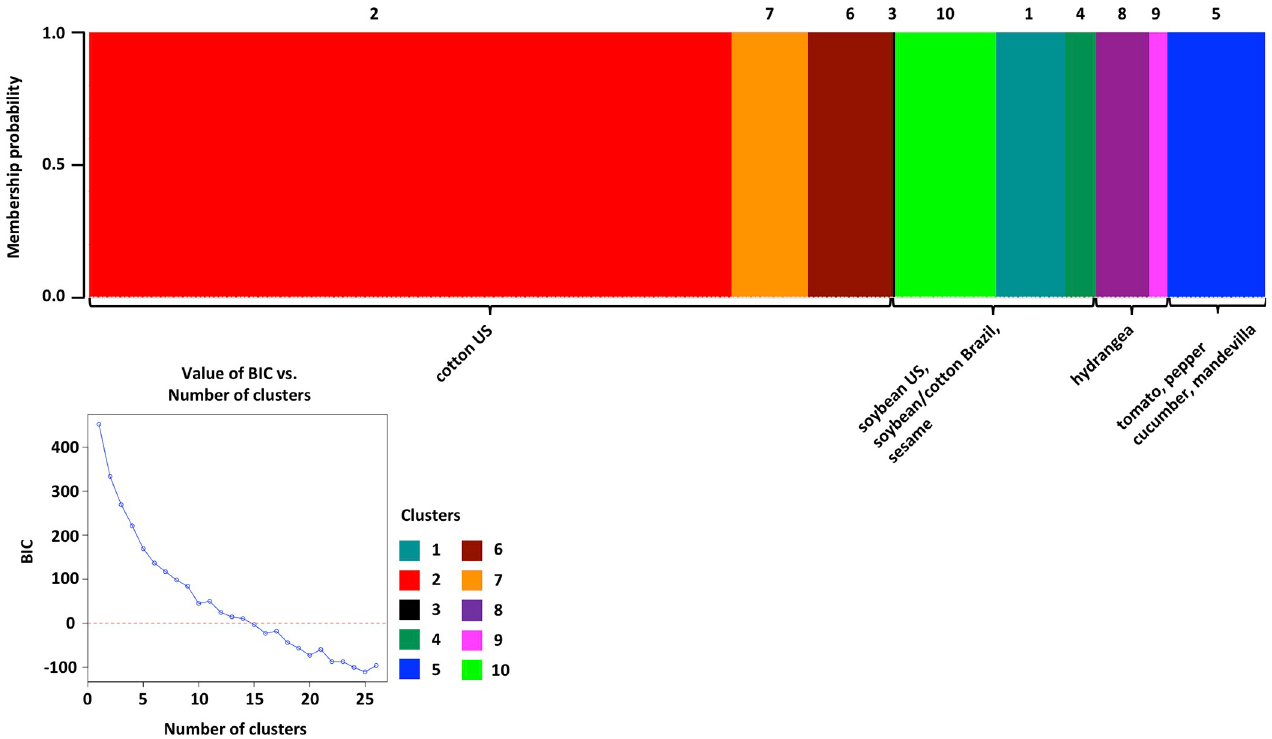
The PCoA analysis (Fig 3) showed clustering of C . cassiicola genotypes from the southeast- ern U.S. based on host of origin. PC1 and PC2 represent 39.9% and 15.0% of the total varia- tion, respectively. The genotypes of cotton and soybean isolates from Brazil clustered with populations from soybean in the southeastern U.S. Most of the genotypes from cotton in the U.S. cluster tightly together; however, two were midway between most U.S. cotton isolates and